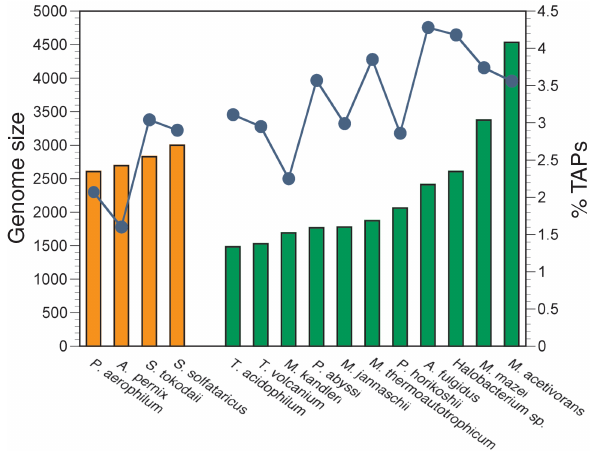
Figure 1. Transcription-associated protein abundance in archaeal lin- eages. The genome sizes of the Crenarchaeota (orange) and Euryarchaeota (green) species are displayed as bar graphs, with the percentage of TAPs present in each of the genomes superimposed as blue line